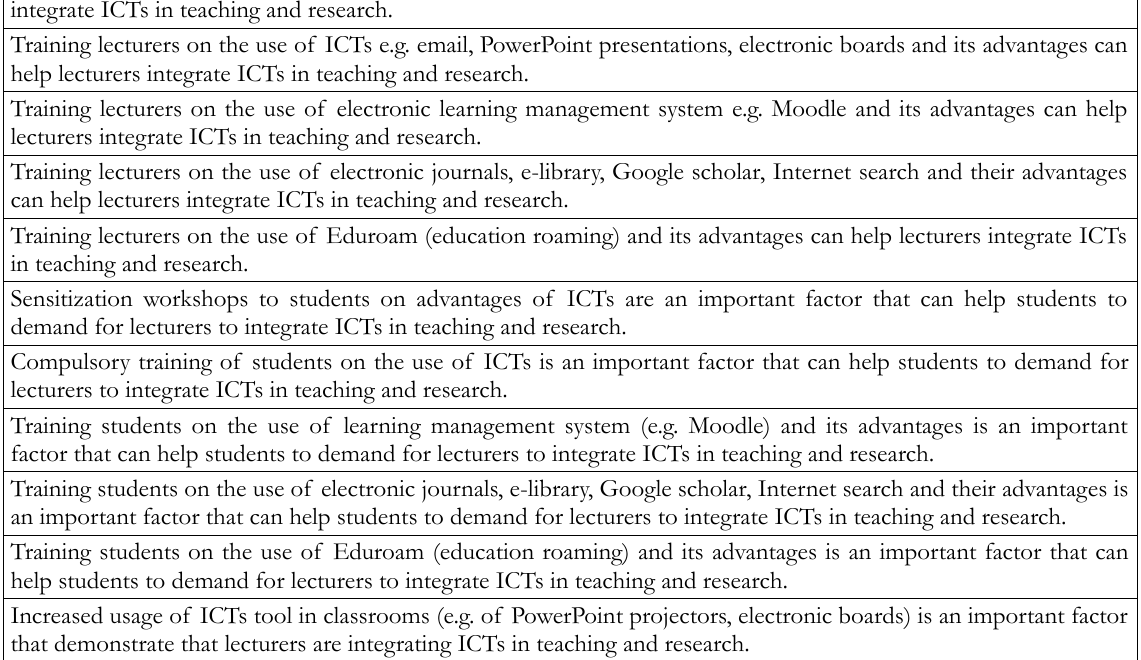
Table 19. Arrangement of